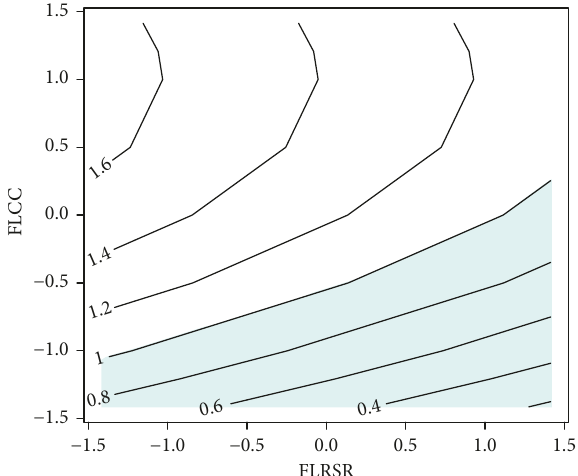
Figure 7: Contour map of uniformity (for the contour map of uniformity 1 as the boundary, the line on blue background in above figure represents the uniformity of rubber distribution that is smaller than 1, and the line on white background represents the uniformity of rubber distribution that is not smaller than